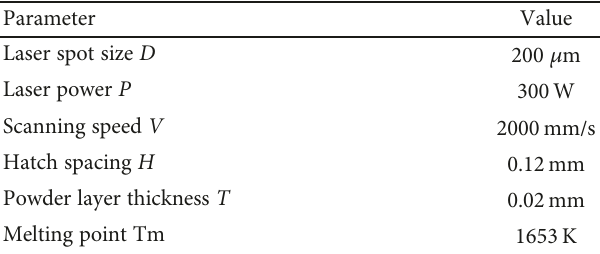
Table 2: Processing parameters during SLM.